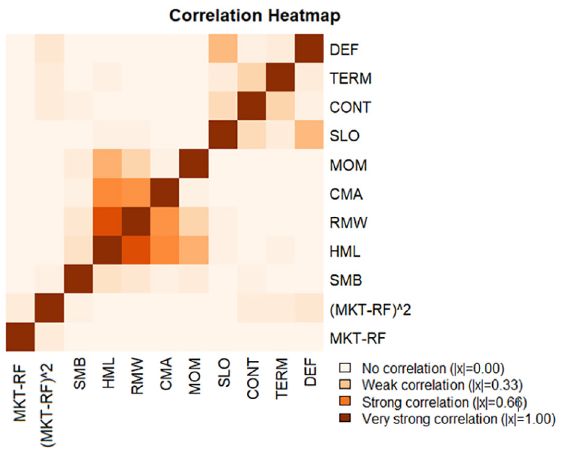
Figure 4. Correlation